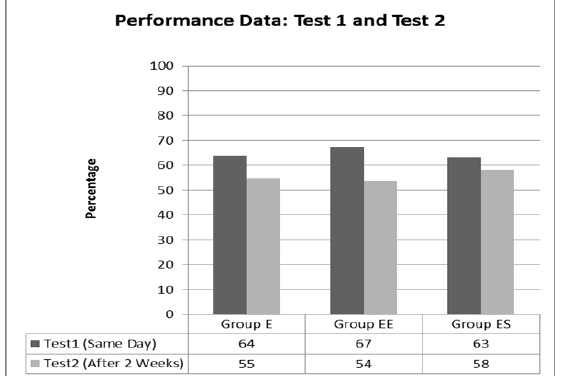
Figure 4. Performance data and information retention between Test 1 and Test